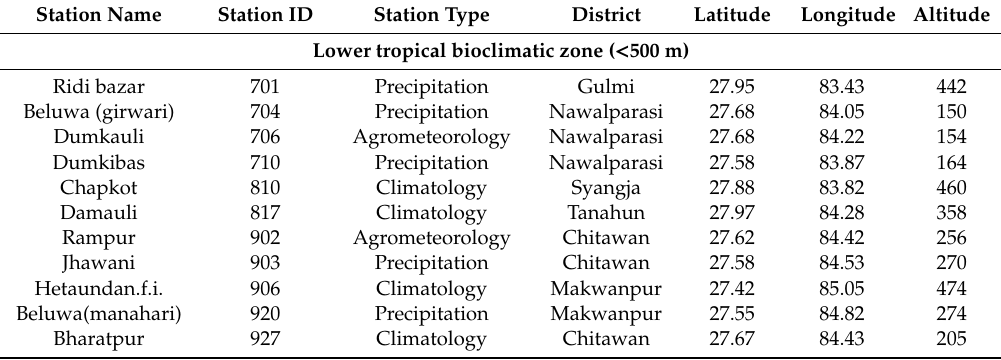
Table A2. Stations used to analyze the precipitation trends in